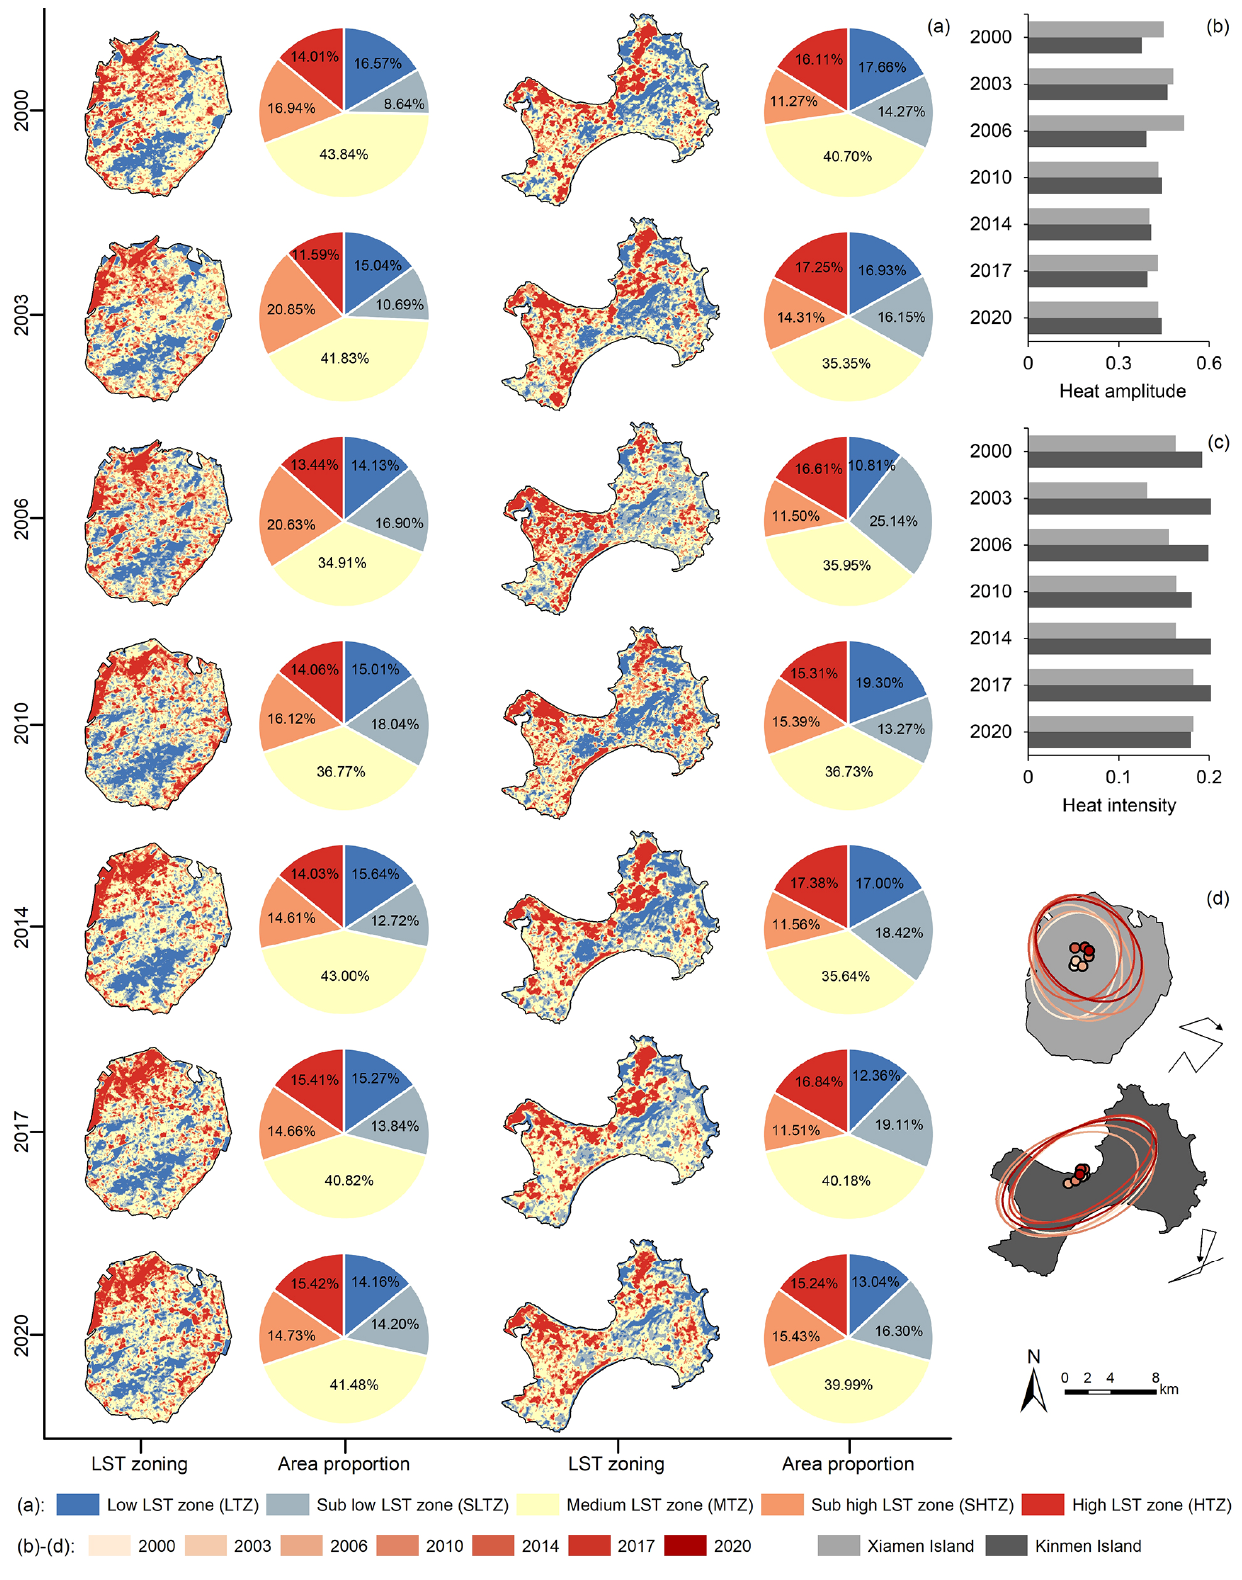
Figure 3. The spatiotemporal change and comparison of STE between Xiamen Island and Kinmen Island from 2000 to 2020. ( a ) The distribution and area proportion of LST zoning; ( b ) Heat amplitude change; ( c ) Heat intensity change; ( d ) Geographical distribution (mean center and directional distribution ellipse) change in